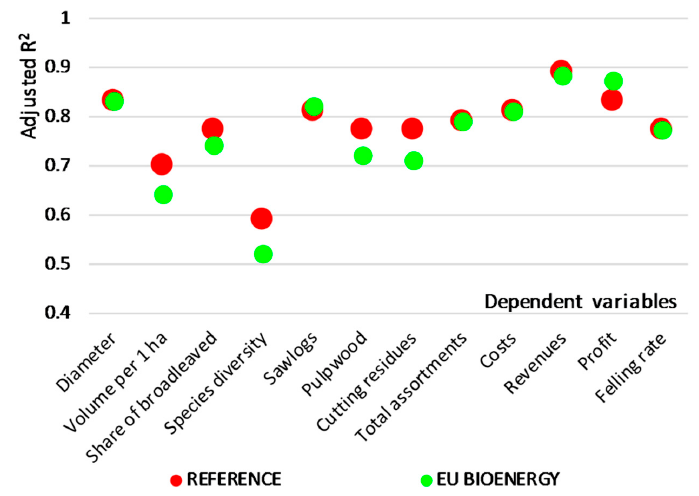
Figure 11. Highest proportions of variance explained in ordinary least square regression models describing the change of key forest and forestry characteristics, due to climate change.